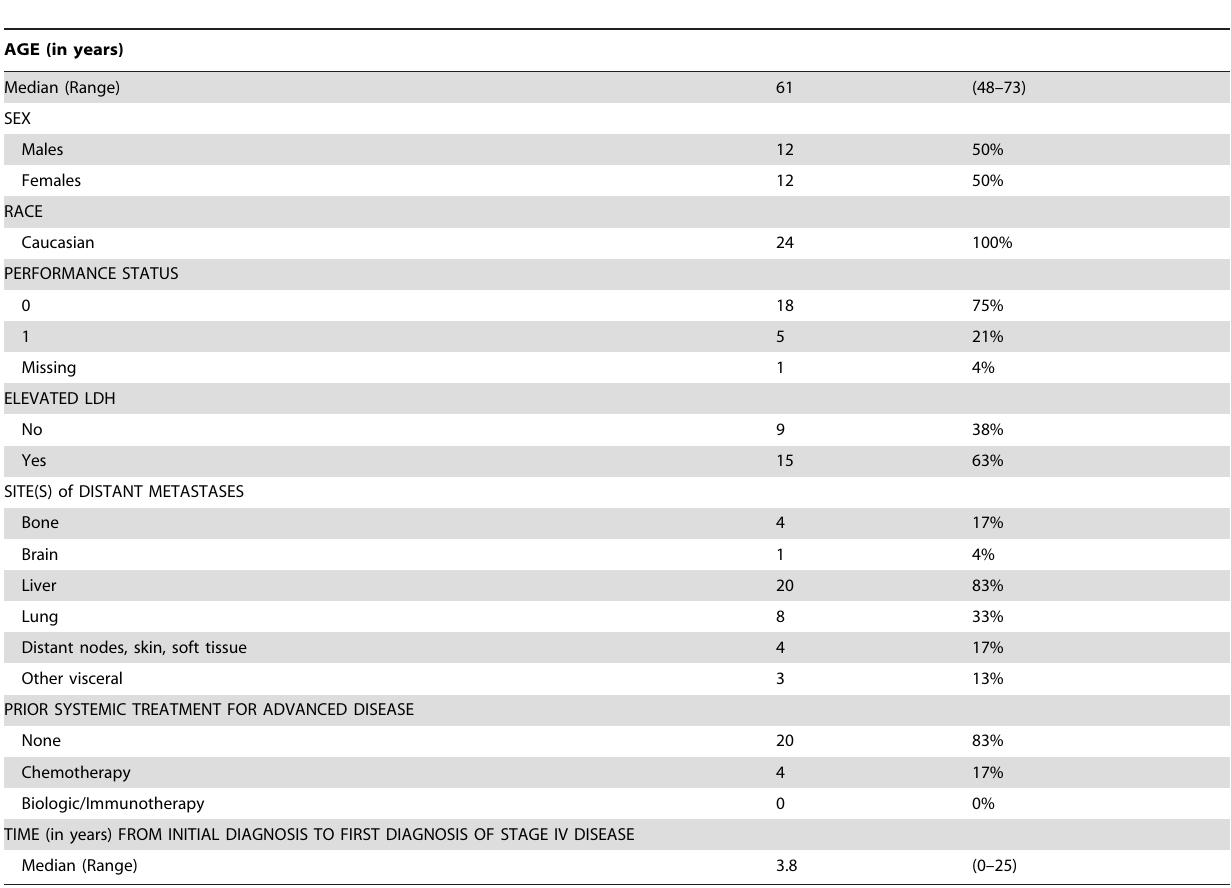
Table 1. Baseline Characteristics and Demographics of 24 Evaluable